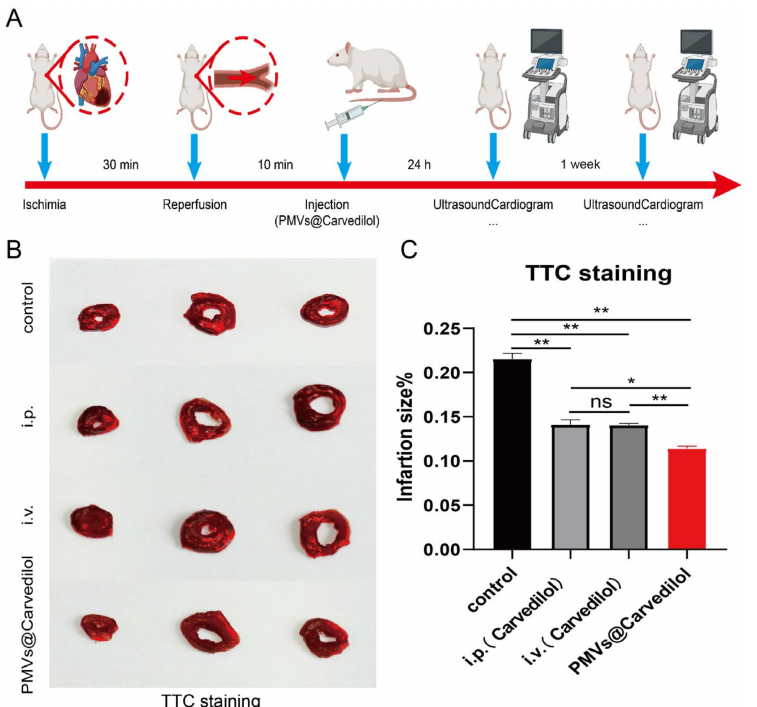
Figure 5. PMVs encapsulation reduces infarction area and boosts therapeutic outcomes in rats with MIRI. ( A ) A schematic showing the animal study design. ( B ) Representative TTC-stained myocardial sections 24 h after treatment (red fluorescence, scar tissue; red, viable myocardium). Scale bar, 2 mm. ( C ) Quantitative analyses of viable myocardium and scar size from the TTC staining images. (i.p. means intraperitoneal injection; i.v. means intravenous injection.) * p < 0.05; ** p < 0.01; ns >